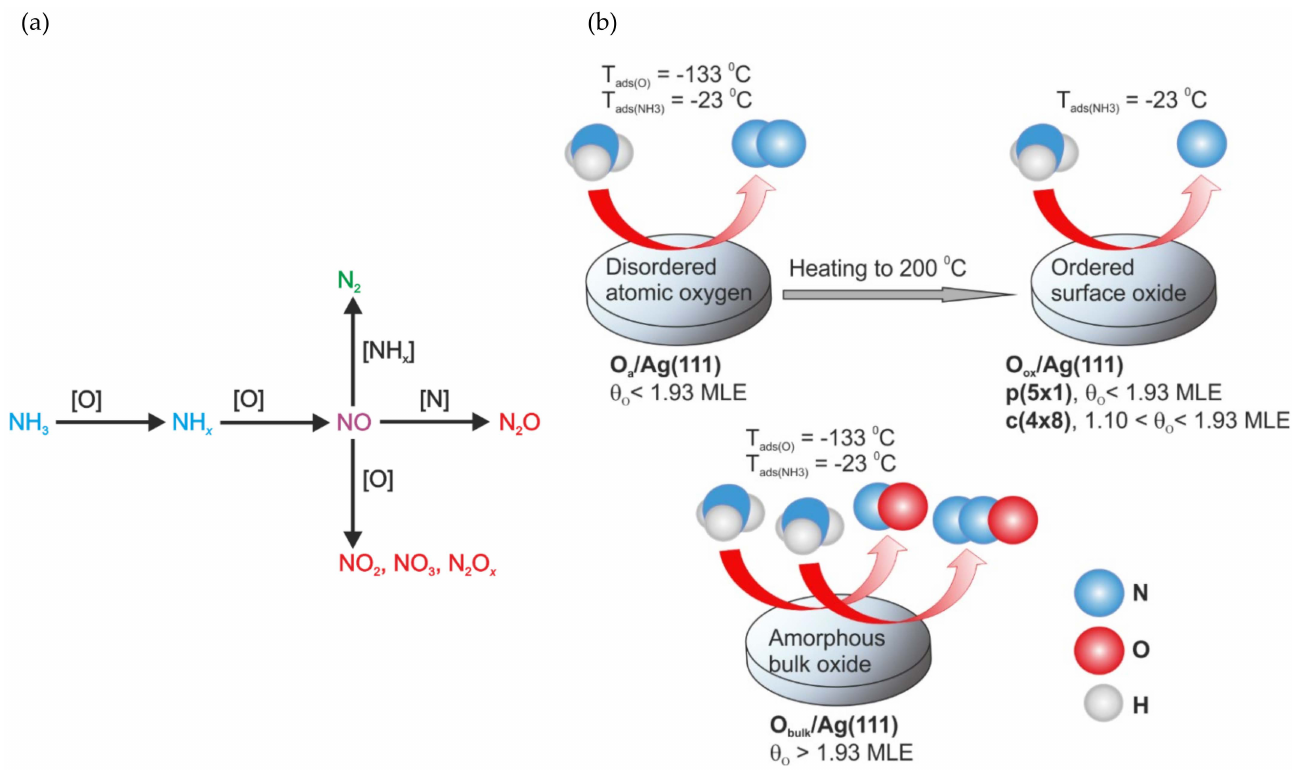
Figure 4. ( a ) Overall NH 3 reaction pathway on silver powder. Reprinted from [84] with permission from Elsevier; ( b ) reactivity and selectivity trends of NH 3 -SCO on O/Ag(111) as a function of the oxygen coverage and temperature. Reprinted from [85] with permission from ACS